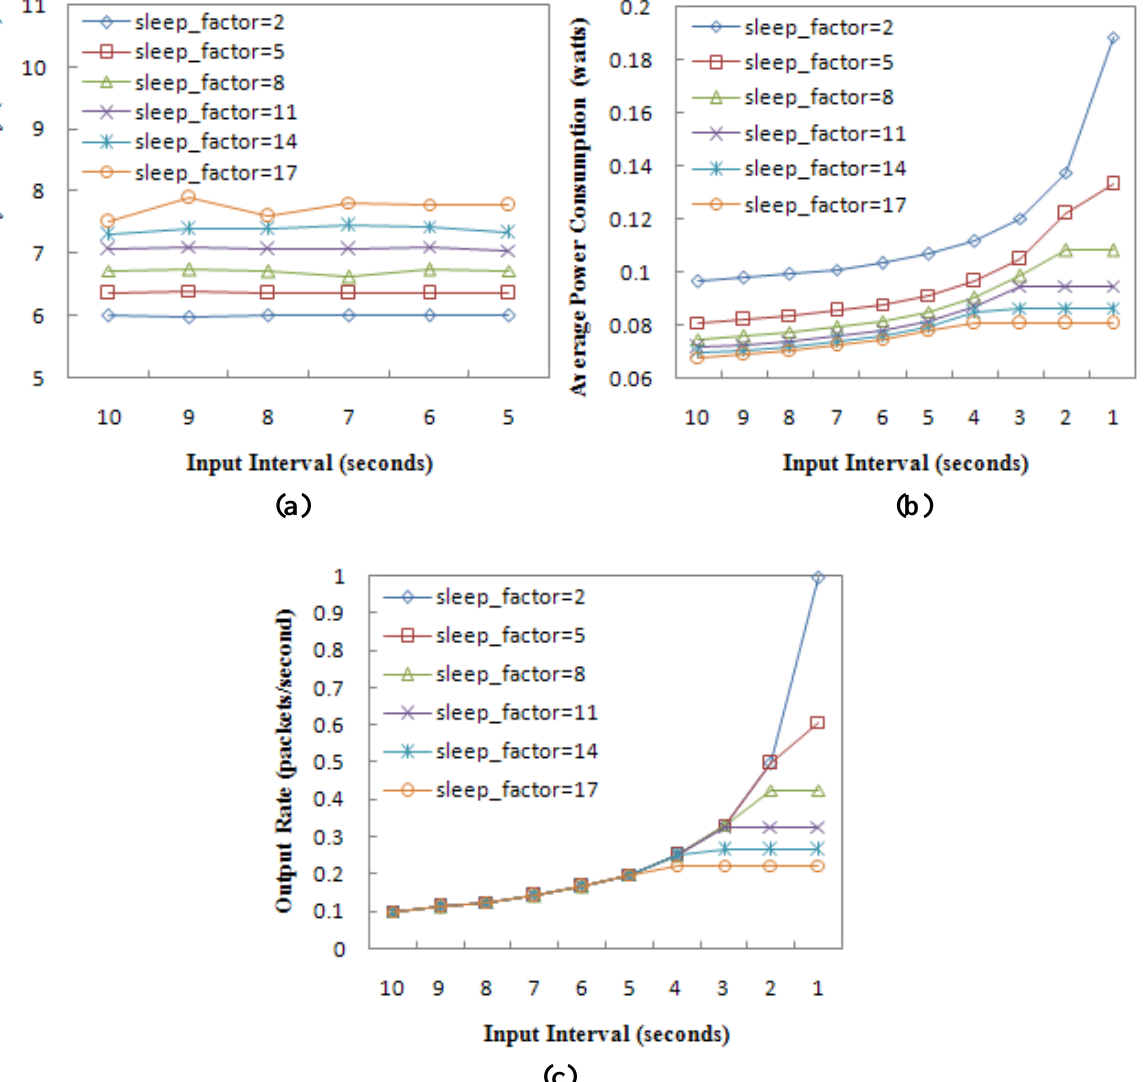
Figure 12. The impact evaluation of sleep_factor in the chain topology, (a) Packet delivery latency. (b) Average power consumption. (c) Output